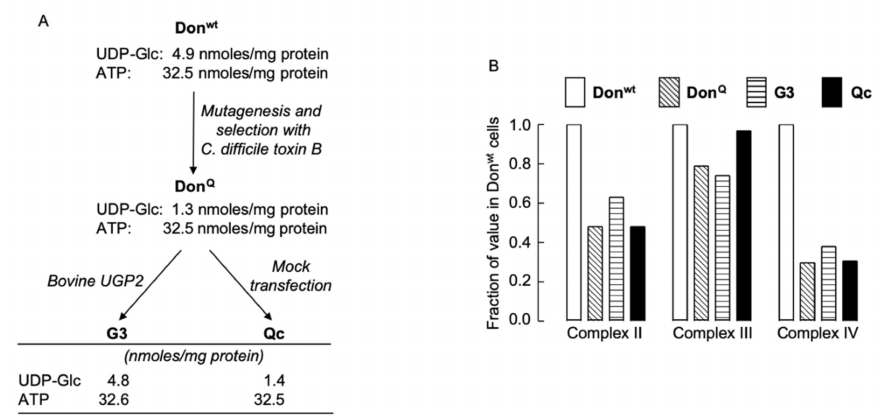
Figure 2. Derivation of UGP-deficient cell lines and examination of their mitochondrial